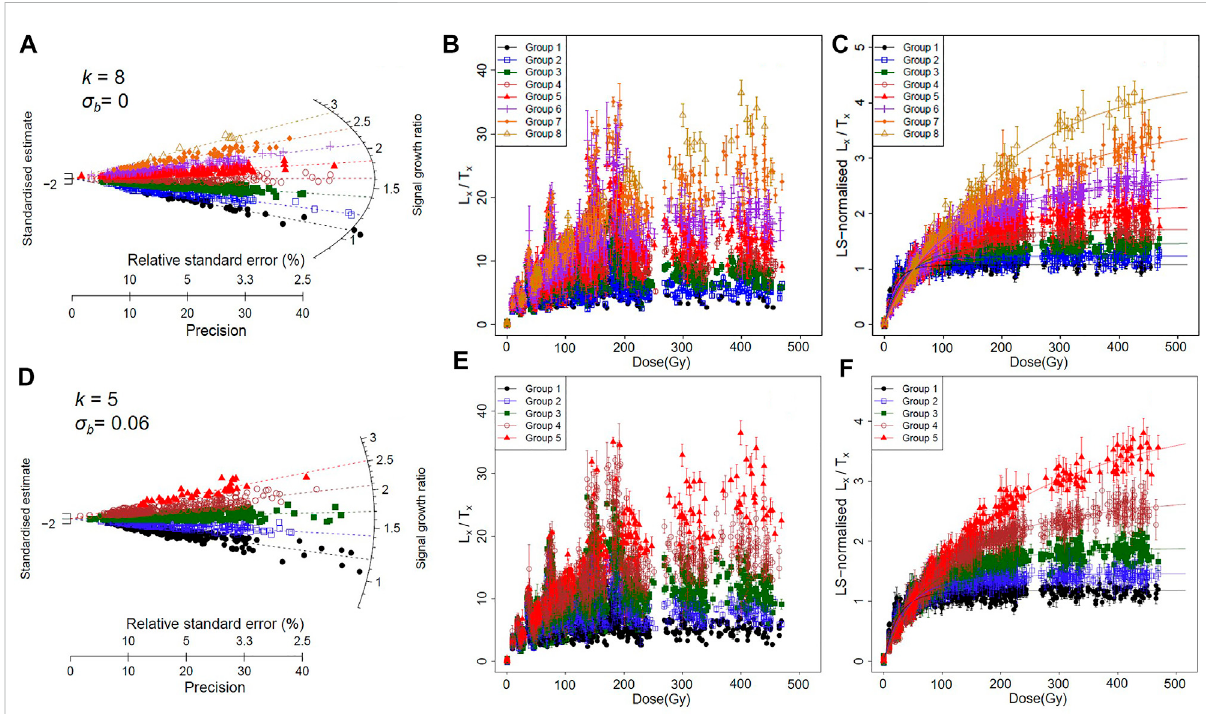
FIGURE 1 (A) Distribution of signal growth ratios for all accepted quartz grains ( n = 1,438) from fi ve Lake Woods samples. Different symbols denote the eightgroupsidenti fi edusingthe fi nitemixturemodeland a σ b valueof0for eachgroup. (B) Single-grainL x /T x ratiosfor theeight groups,plottedasa function of laboratory dose. (C) LS-normalized L x /T x ratios for the eight groups, based on the data shown in (B) . (D) Same data in (A) but divided into fi vegroupsbytheFMM( σ b =0.06). (E) Single-grain L fi vegroupsin (D) . (F) LS-normalized L fi vegroups, based x /T x ratiosforthe x /T x ratiosforthe on the data shown in (E)